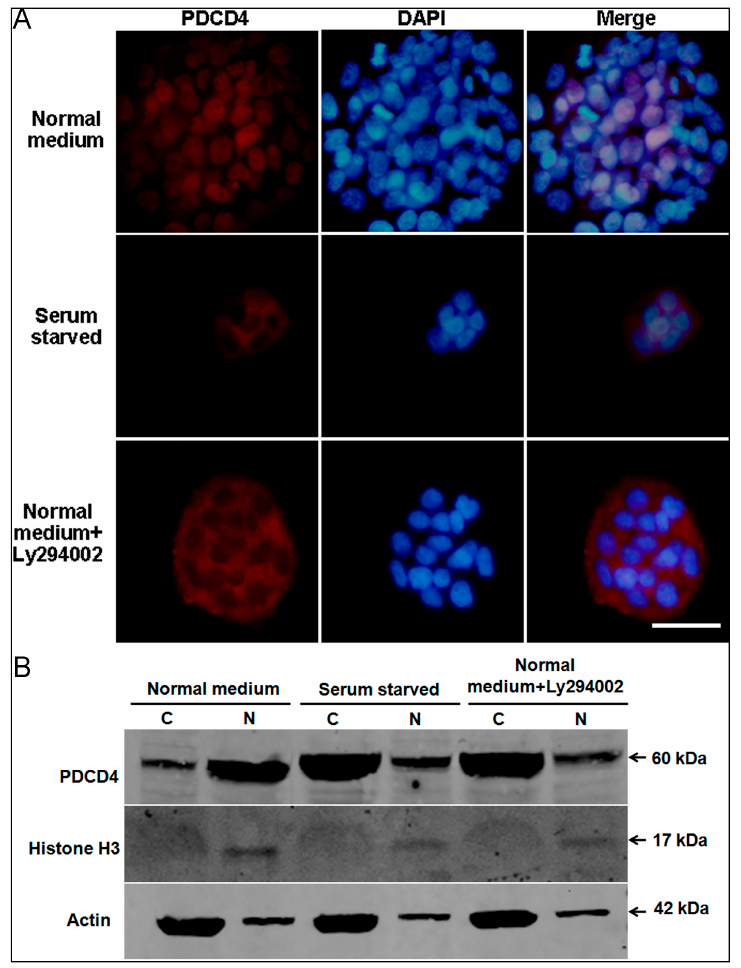
Figure 5. Intracellular translocation of PDCD4 in HaCaT cells. ( A ) Endogenous PDCD4 in HaCaT cells was localized exclusively in the nucleus when cultured in medium with serum ( top panel ). PDCD4 translocated from nucleus to cytoplasm under serum starvation treatment overnight ( middle panel ). In medium with serum, cytoplasmic localization of PDCD4 was observed, when cells treated with PI3K inhibitor Ly294002 ( bottom panel ). Scale bar = 30 μ m; ( B ) PDCD4 was detected by Western blot of both cytosolic (C) and nuclear (N) protein fractions of HaCaT under different treatment conditions.